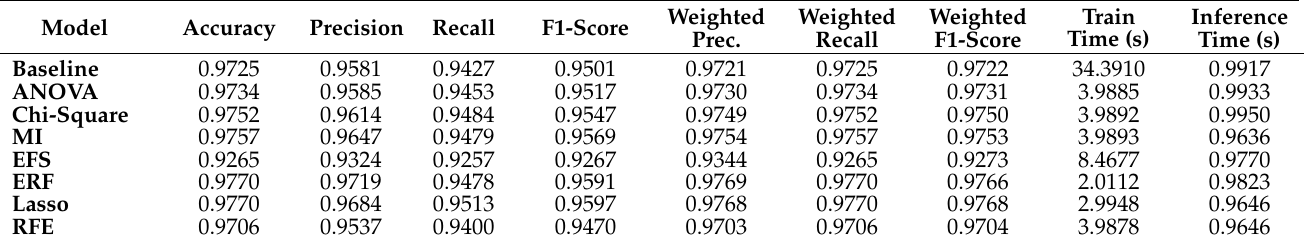
Table 3. The performance metrics of feature selection